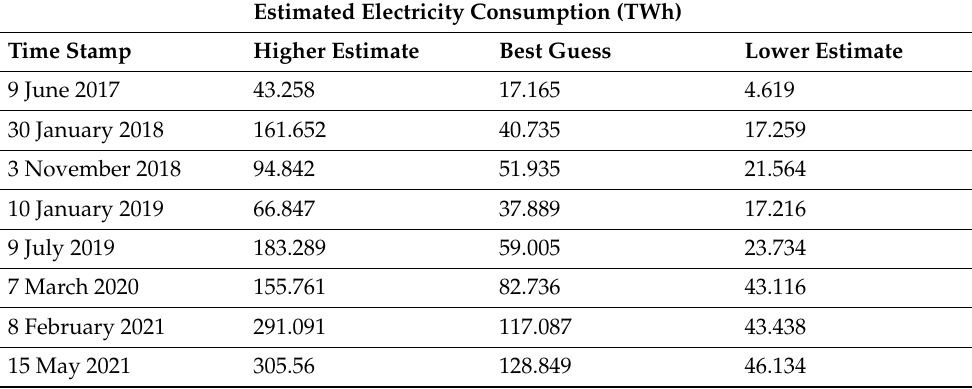
Table 3. Bitcoin’s electricity usage worldwide (Estimated electricity consumption (terawatt-hours,